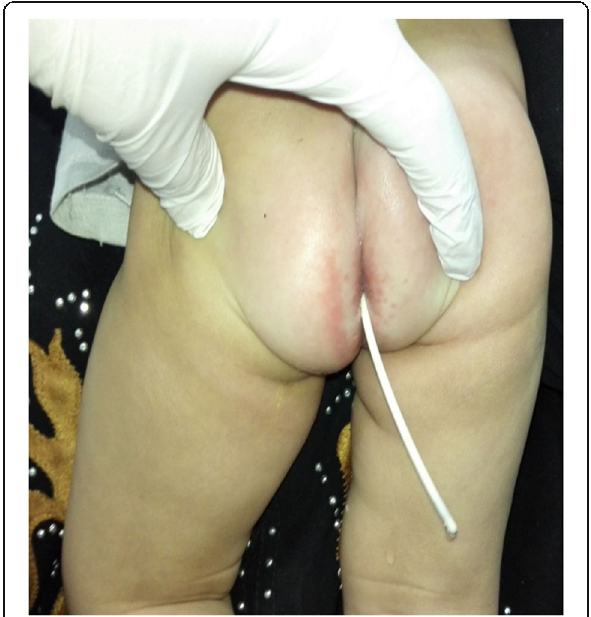
Fig. 9 Photograph of a 13-month-old male infant showing extrusion of the distal end of the distal catheter through the anus with CSF drainage